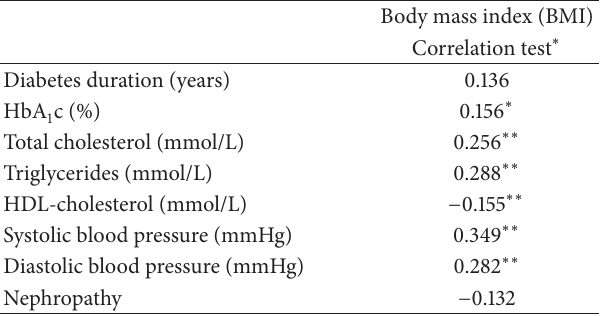
Table 8: Correlation between diabetic retinopathy and diabetes duration, body mass index, and metabolic and clinical parameters in type 1 diabetic patients without nephropathy ( 𝑛 = 124 ).